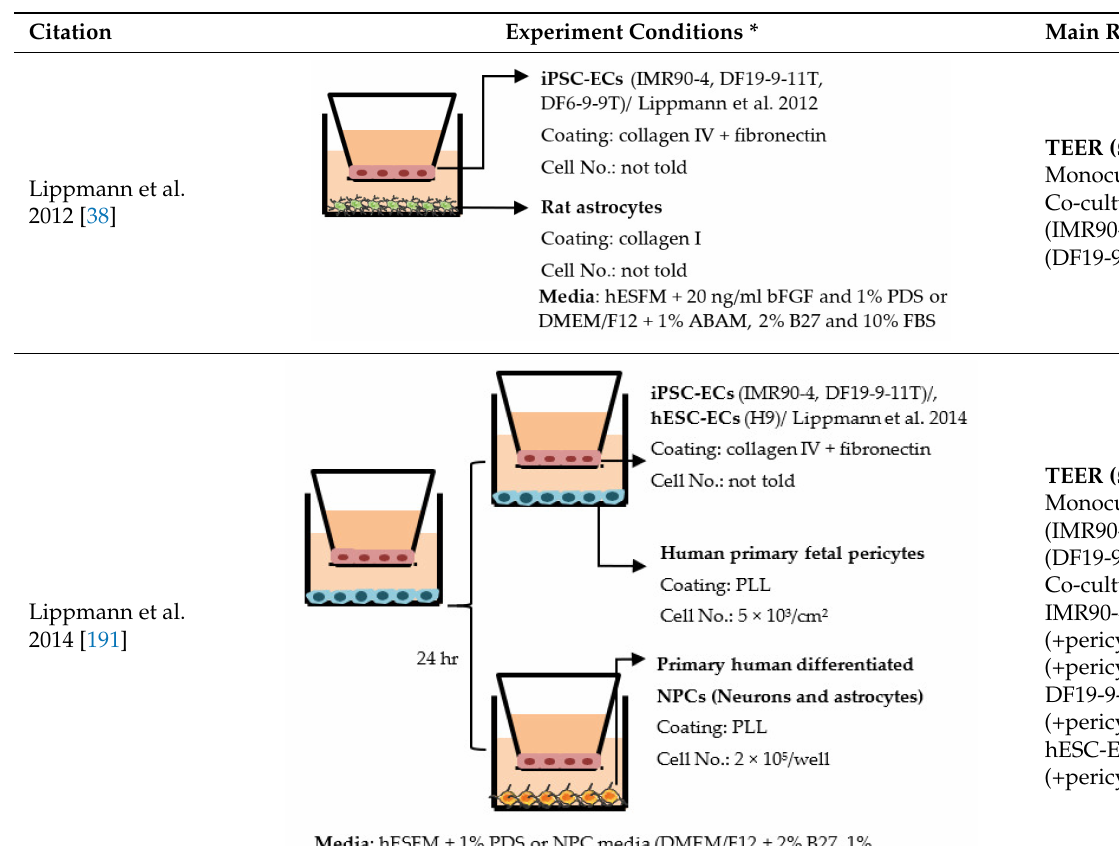
Table 1. Blood–brain barrier in vitro models